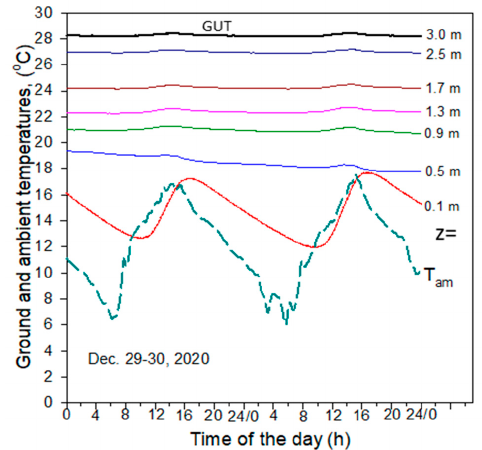
Figure 2. Diurnal variation in ambient temperature ( T am ) and underground soil temperature ( T g ) at different depths ( z ) in winter season (29–30 December 2020).